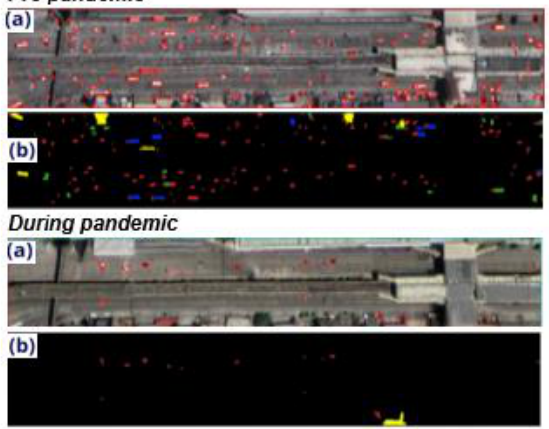
Figure 4. Vehicles in Triangle Park delineated in (a) Google